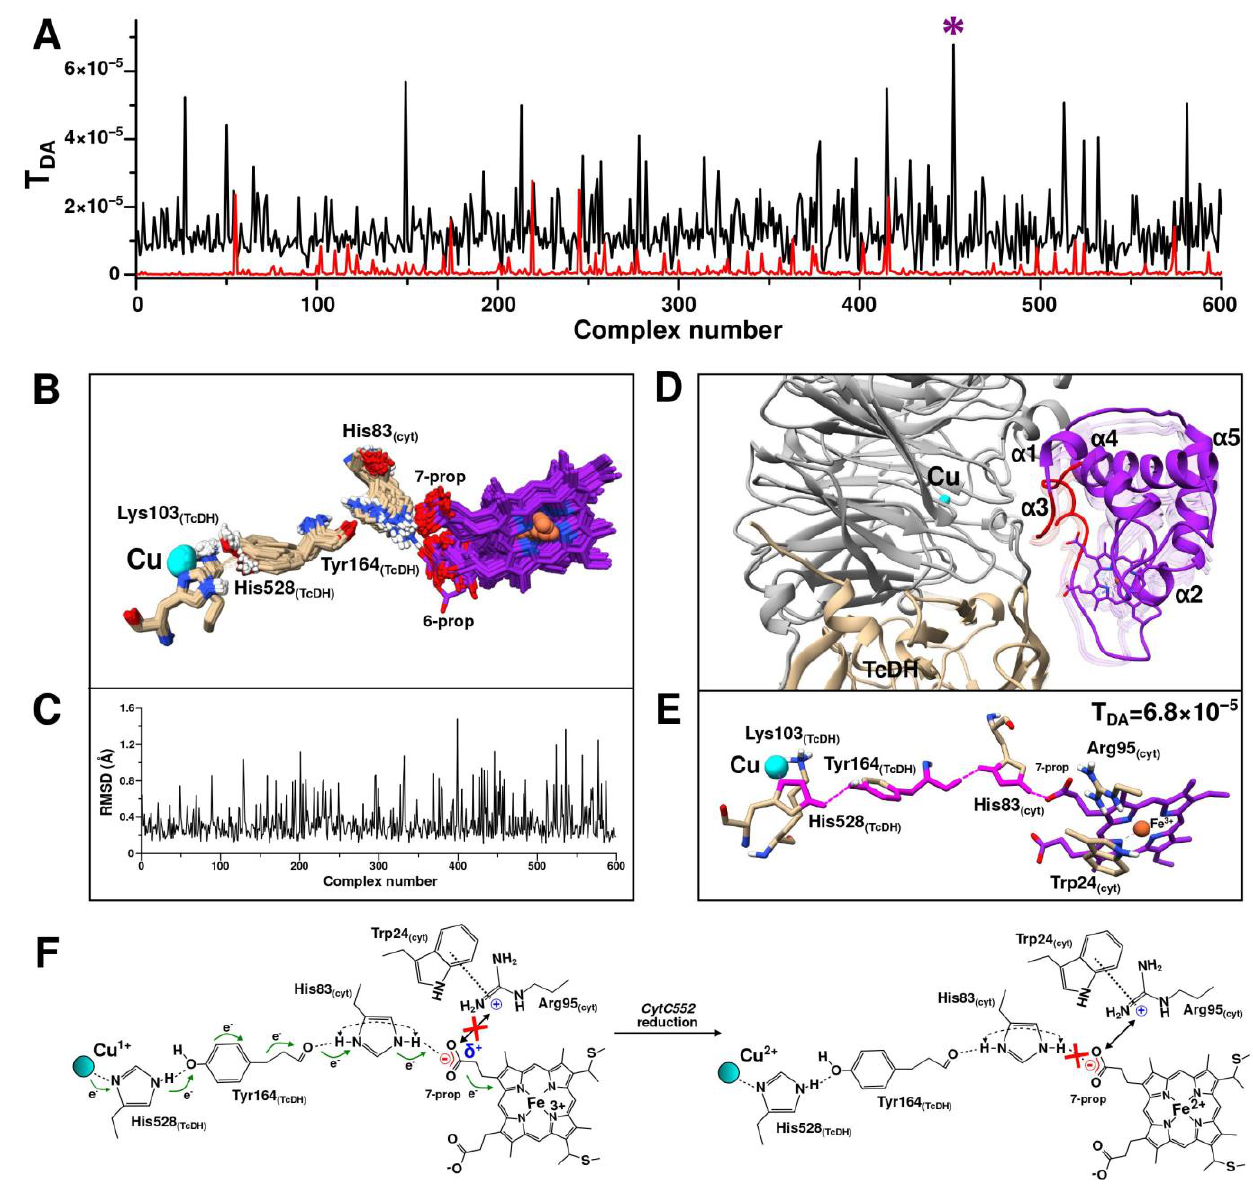
Figure 9. Second stage of the TcDH-CytC552 complex structure prediction using HADDOCK (driven by unambiguous restraints) and Pathways program. ( A ) Plots of electron coupling constant (T DA ) depending on structure number from HADDOCK calculations with unambiguous restraints (black) and from the first stage of modeling with ambiguous restraints (red). Violet asterisks indicate the complex with highest T DA values. ( B ) Superposition of structures of 600 HADDOCK complexes. Only the heme group and residues involved in ET are shown for clarity. ( C ) Plot of backbone atoms RMSD for all 600 structures relative to the average structure. ( D ) Structure of the complex with highest T DA value. Superimposed structures from the first stage of modeling are shown as semi-transparent ribbon (from Figure 9B). ( E ) Predicted ET pathway (which started upon Cu2 ion reduction) for the complex with highest T DA value. ( F ) Scheme of the electron transfer pathway between TcDH and CytC552. The black double arrow indicates a strong ionic interaction. The red cross on the left scheme indicates the absence of strong ionic interaction, and on the right scheme it indicates the absence of the corresponding hydrogen bond.